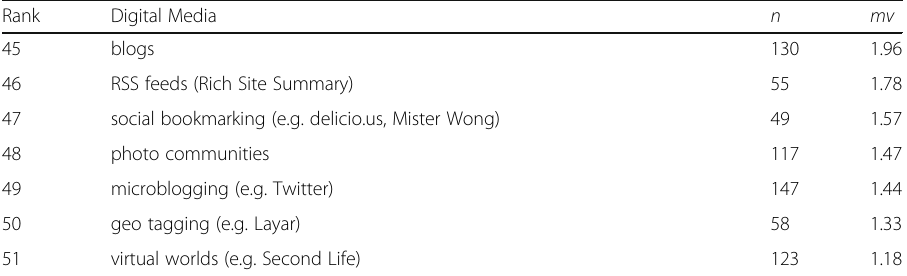
Table 4 Ranking by mean - ‘ How useful do you find these digital media tools for your studies? ’